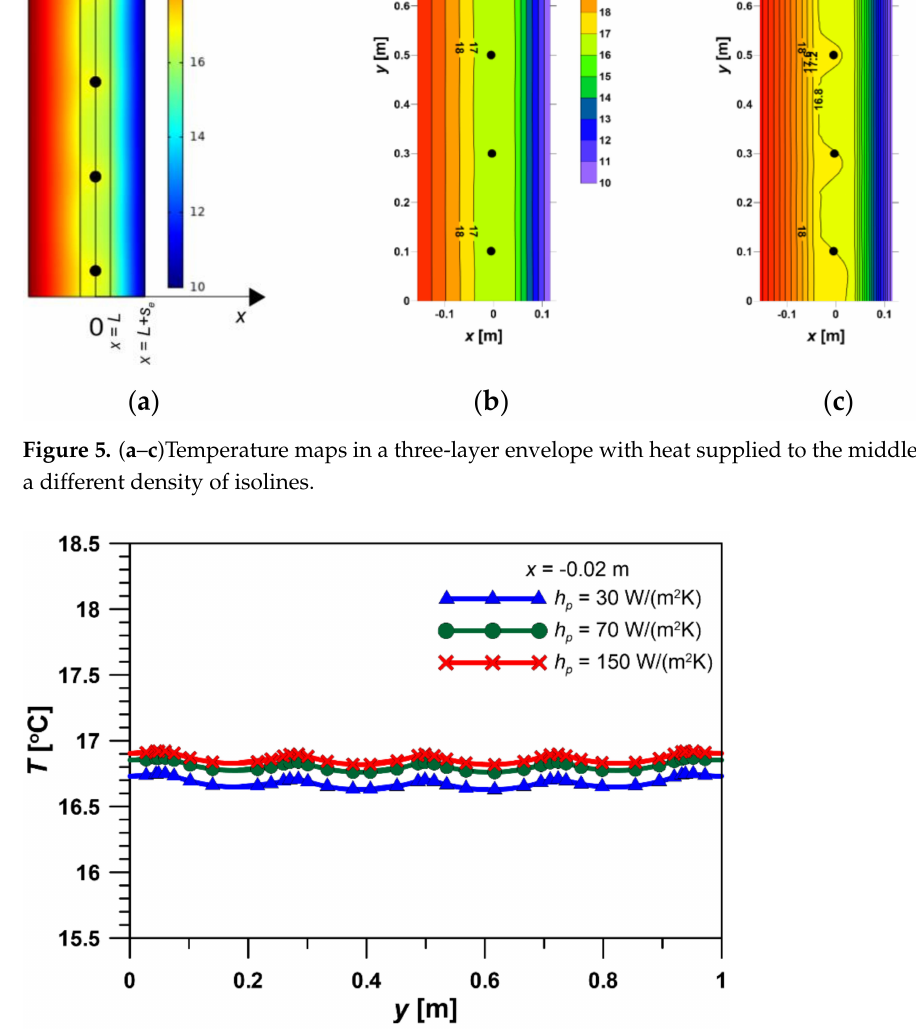
Figure 6. Temperature distribution in the vertical section of a reinforced concrete layer. The temperature distribution in the T - x co-ordinate system for different values of h p and the different values of y is shown in Figure 7. In all cases, the temperature profiles in the insulation layers are linear. In contrast, the profile is almost flat in the reinforced concrete layer. The profiles for the different values of the y -co-ordinate are virtually identical. The value of the heat transfer coefficient slightly influences the temperature; for extreme values of h p = 30 W/(m 2 K) and h p = 150 W/(m 2 K), the temperatures differ by only 0.2